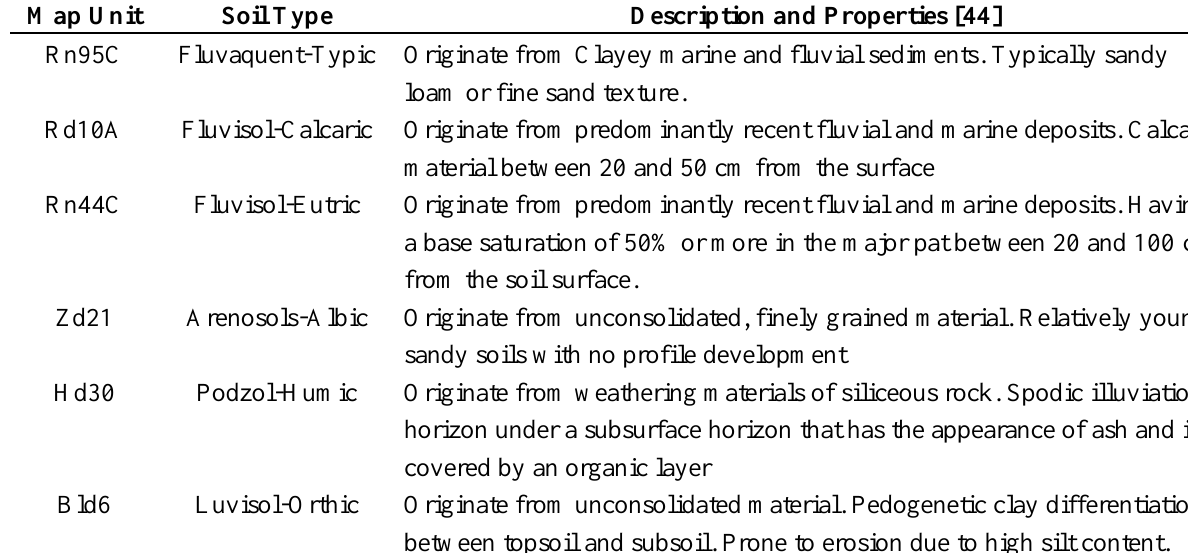
Table 1. Description of sampled soils in the